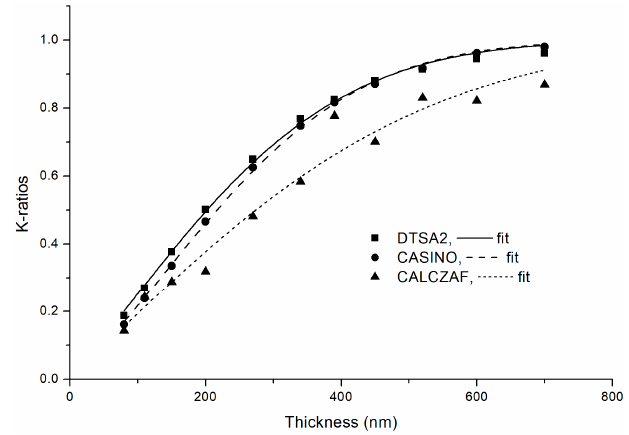
Figure 3. Examples of simulated data and fitted calibration curves. Curves of 30 keV Au K-ratios.